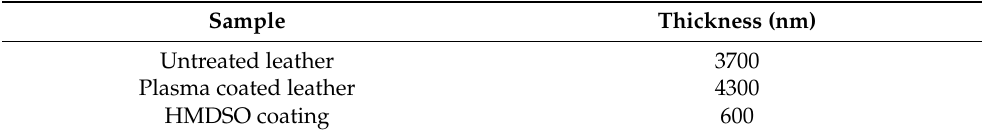
Table 6. Thickness values of untreated, plasma treated samples and plasma polymerised HMDSO coating.